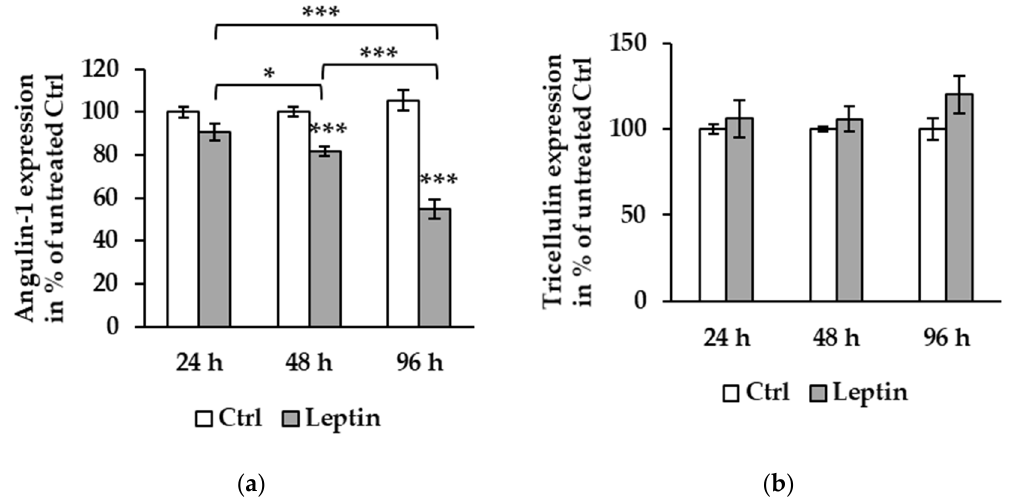
Figure 3. Protein expression effect of leptin at different time points in T84 cells. ( a ) Densitometric analysis shows angulin-1 expression to be 90.68 ± 3.83% at 24 h ( n = 6), 81.11 ± 2.07% at 48 h (*** p < 0.001, n = 12), and 58.66 ± 2.62% at 96 h (*** p < 0.001, n = 12) compared to untreated Ctrl. The protein expression at 96 h is decreased compared to both 24 (*** p < 0.001) and 48 h (*** p < 0.001). At 48 h, angulin-1 expression is also lower than 24 h (* p < 0.05). ( b ) Tricellulin expression level shows no differences between 24 ( n = 6), 48 ( n = 12), and 96 h ( n = 12).